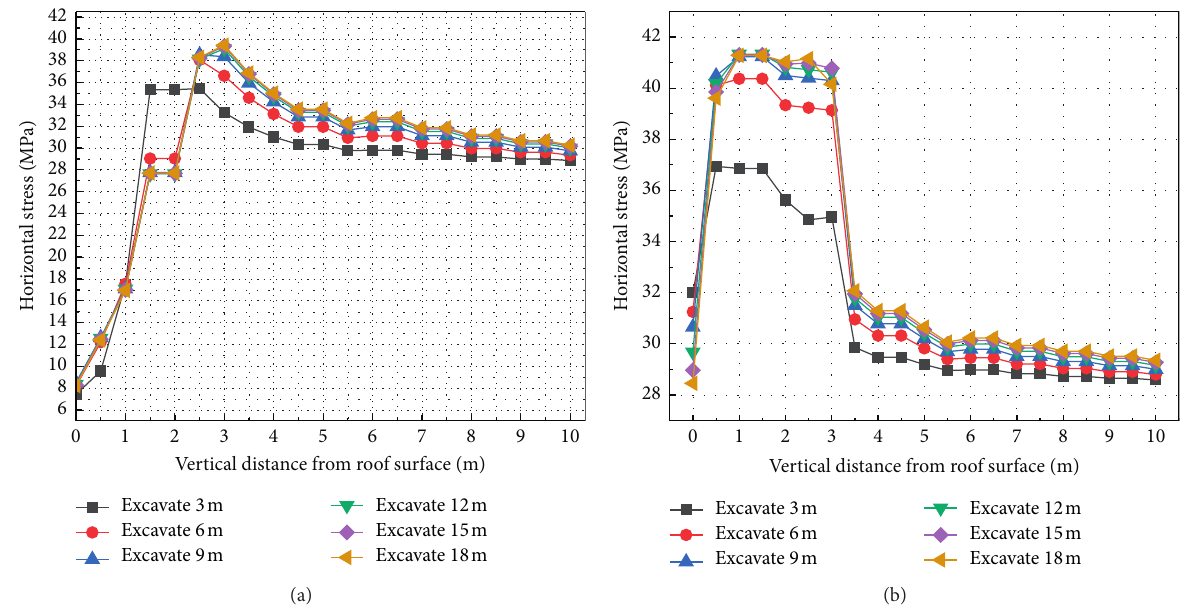
Figure 9: Horizontal stress evolution under different excavation distance without and with surrounding rock grouting. (a) Without surrounding rock grouting. (b) With surrounding rock